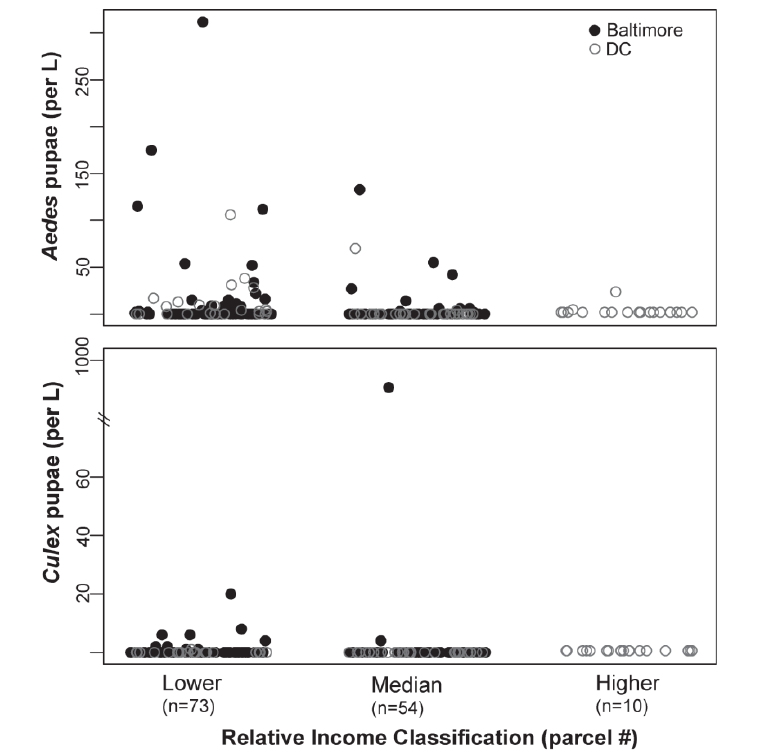
Figure 1. Pupae densities were higher in Baltimore container habitats and in lower income category neighborhoods within each city. Note break in y-axis in bottom panel due to high Culex pupae counts in one tire habitat in